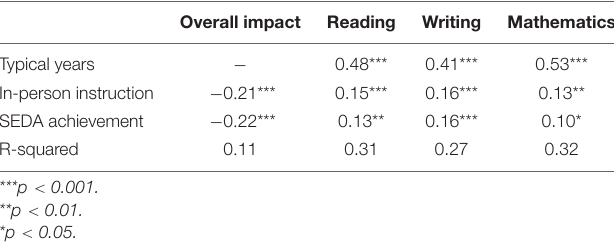
TABLE 1 | Standardized regression coefficients predicting overall impact and coverage of curriculum.